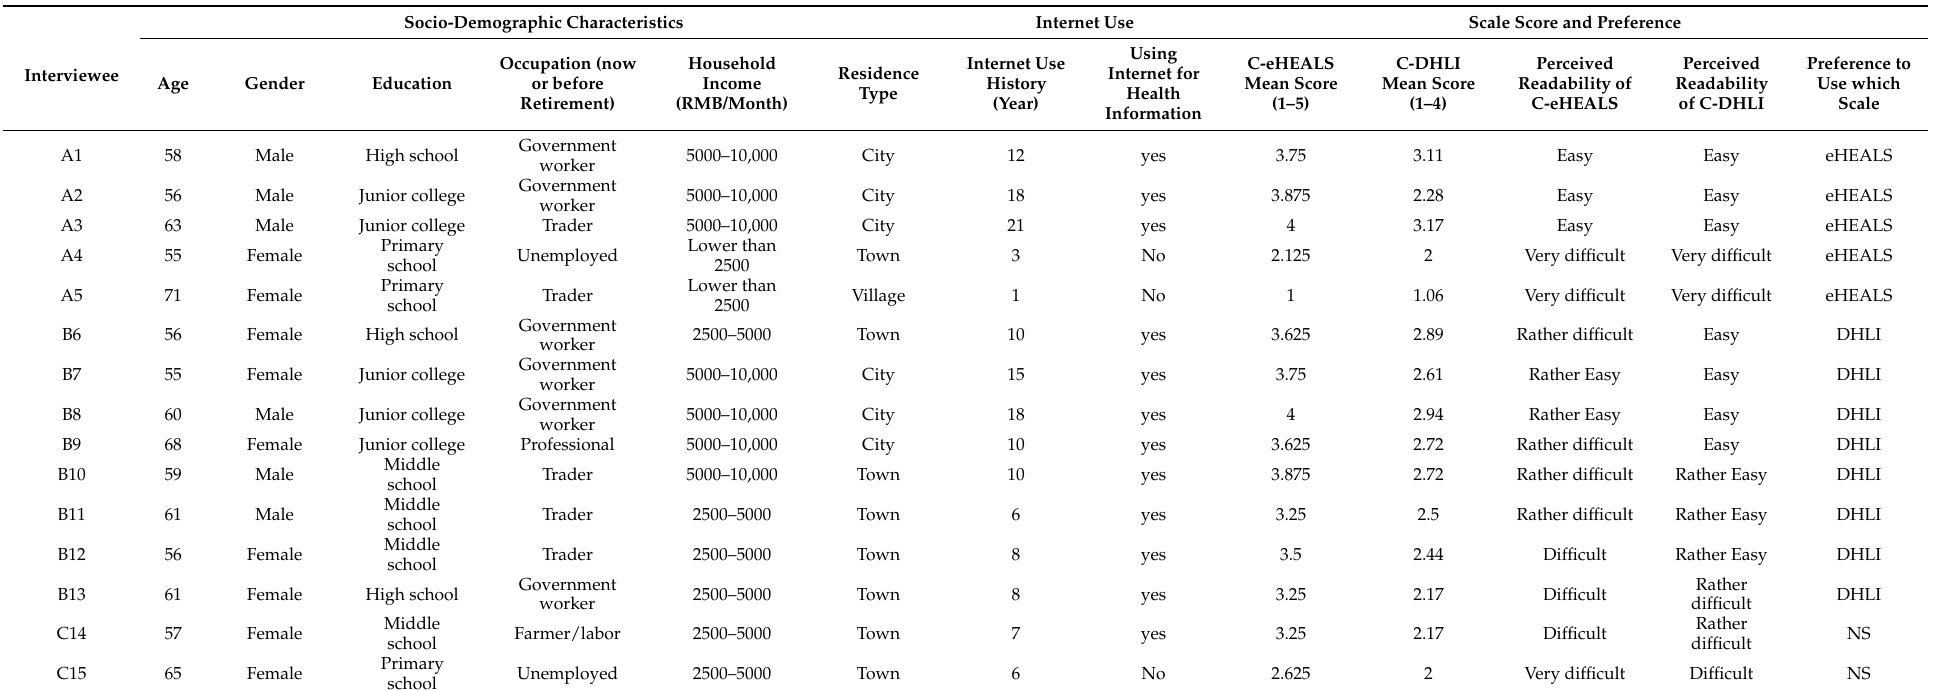
Table 3. Characteristics and qualitative results of interviewees (N =